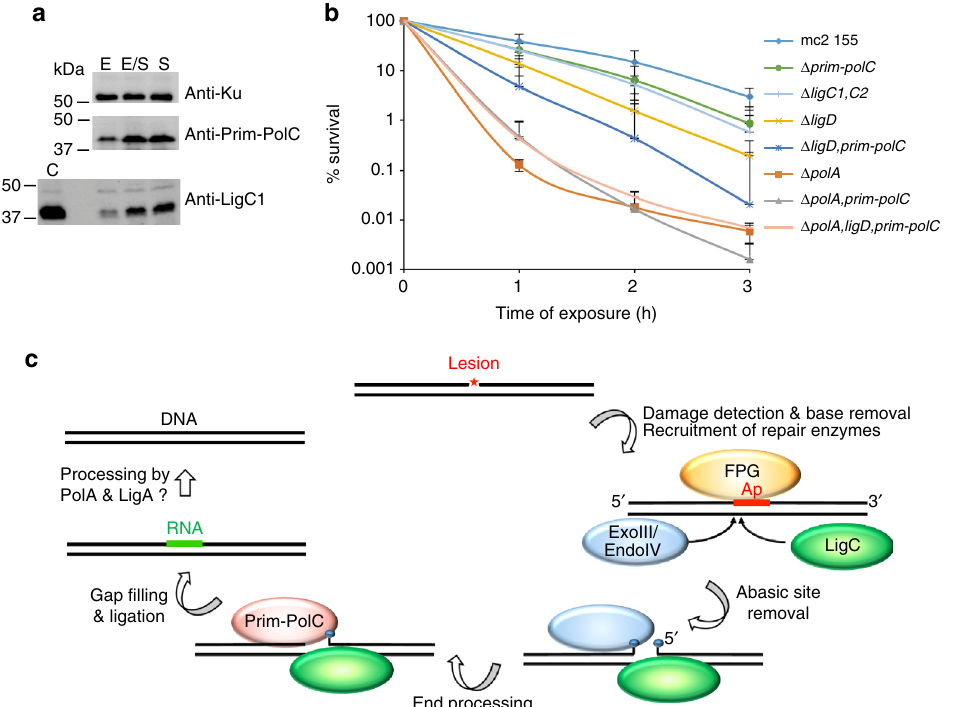
Fig. 6 Expression of Prim-PolC and LigC1 in vivo and phenotypes associated with their deletion. a Expression pro fi ling using western blotting. Speci fi c antibodies raised against LigC1, Prim-PolC and Ku proteins were used to probe for corresponding proteins in whole-cell lysates obtained from M. smegmatis cells grown to various growth phases including, exponential (E ” ), early stationary (E/S) and stationary (S) phase. b A plot of colony forming units (CFU) data showing the survival of wild-type (MC 155) or mutant cells, lacking Prim-Pols and/or ligases, treated with 10 mM cumene hydroperoxide. Cells were plated at 1, 2 or 3 hours after treatment and the percentage survival is calculated against untreated control cells, treated with diluted buffer instead of peroxide. Data are representative of the mean of fi ve individual experiments and error bars show the standard deviation. c A model of the repair of a damaged base by the LigC-dependent excision repair complex. The damage is initially recognised by speci fi c mono or bifunctional glycosylases, whose activity results in the formation of an abasic site intermediate. LigC is recruited early to the lesion to coordinate later repair steps and mediate multi-protein repair complex formation. Short gaps produced by processing of the lesion by the BER machinery are then fi lled in with RNA by Prim-PolC and the resulting nick is ligated by LigC. RNA is probably later excised and replaced with DNA catalysed by PolA and the nicked DNA intermediate sealed by